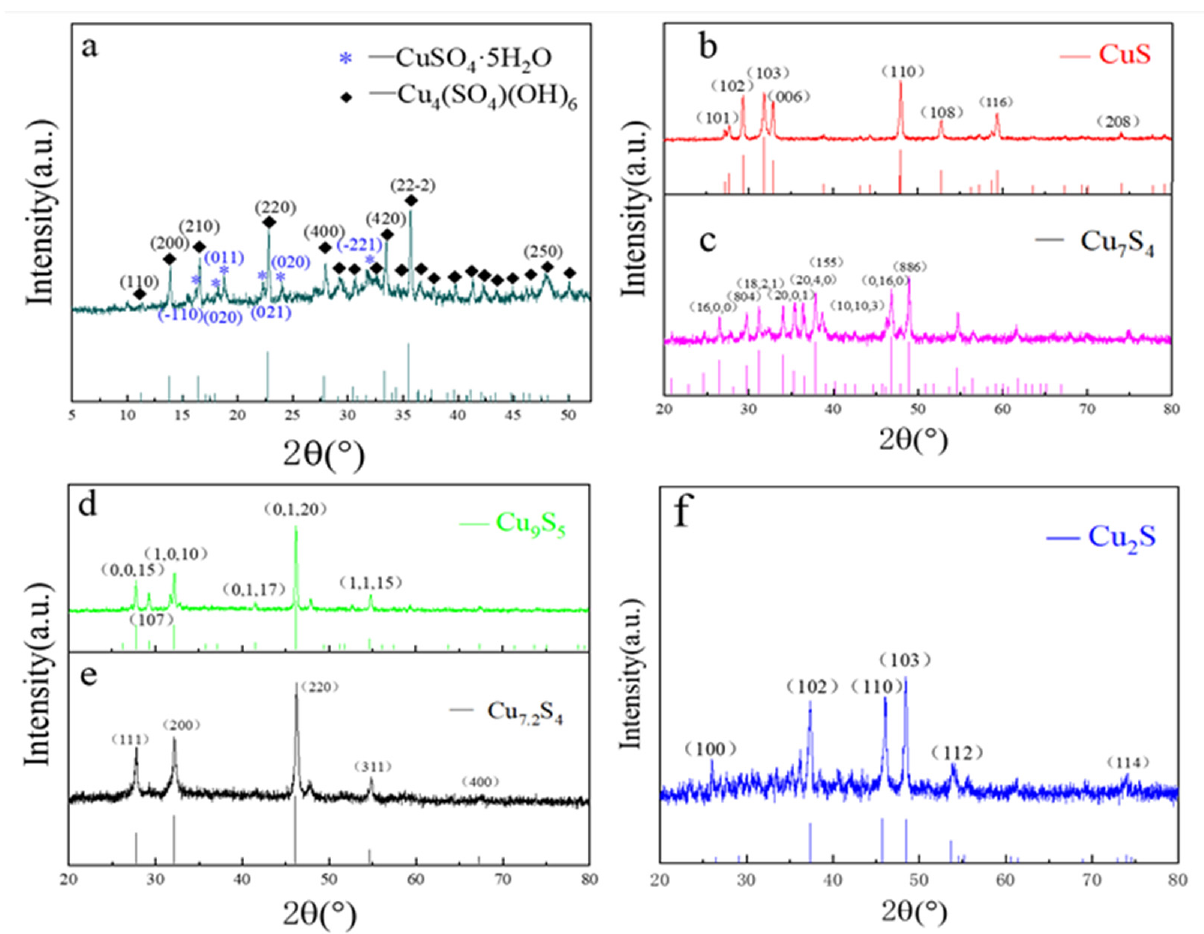
Figure 1. ( a ) is the XRD patterns figure of intermediates prepared by Cu(CH 3 COO) 2 ·H 2 O and TAA; ( b – f ) are the XRD patterns figures of CuS, Cu 7 S 4 , Cu 9 S 5 , Cu 7.2 S 4, and Cu 2 S.